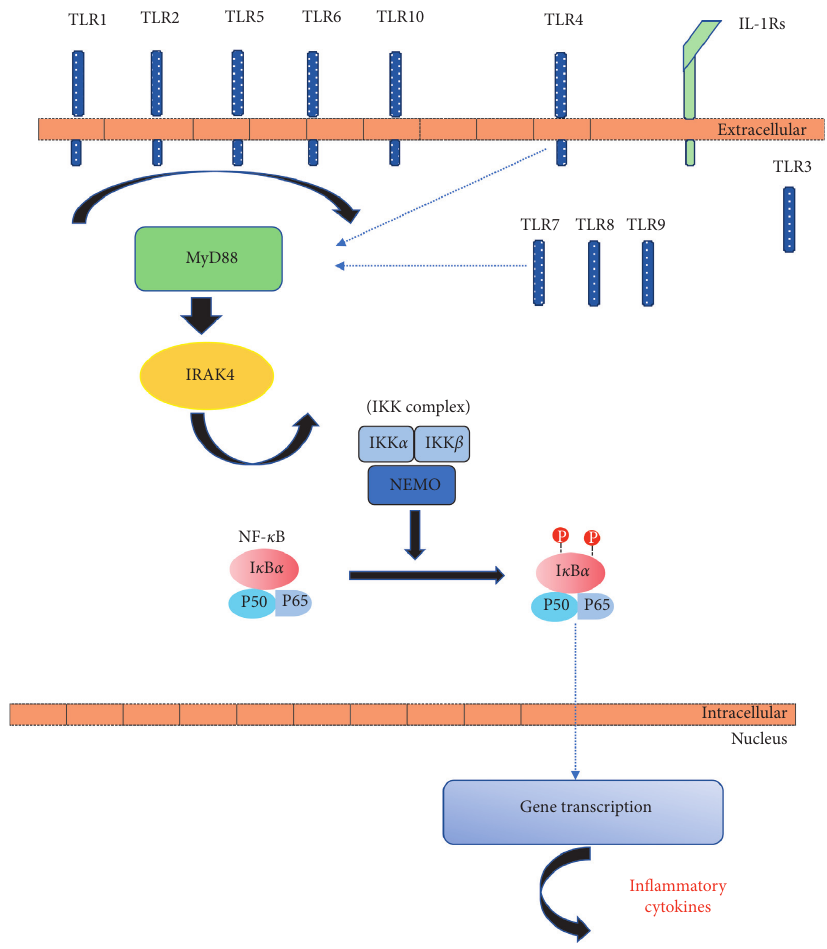
Figure 2: MyD88 and IRAK-4-mediated signaling